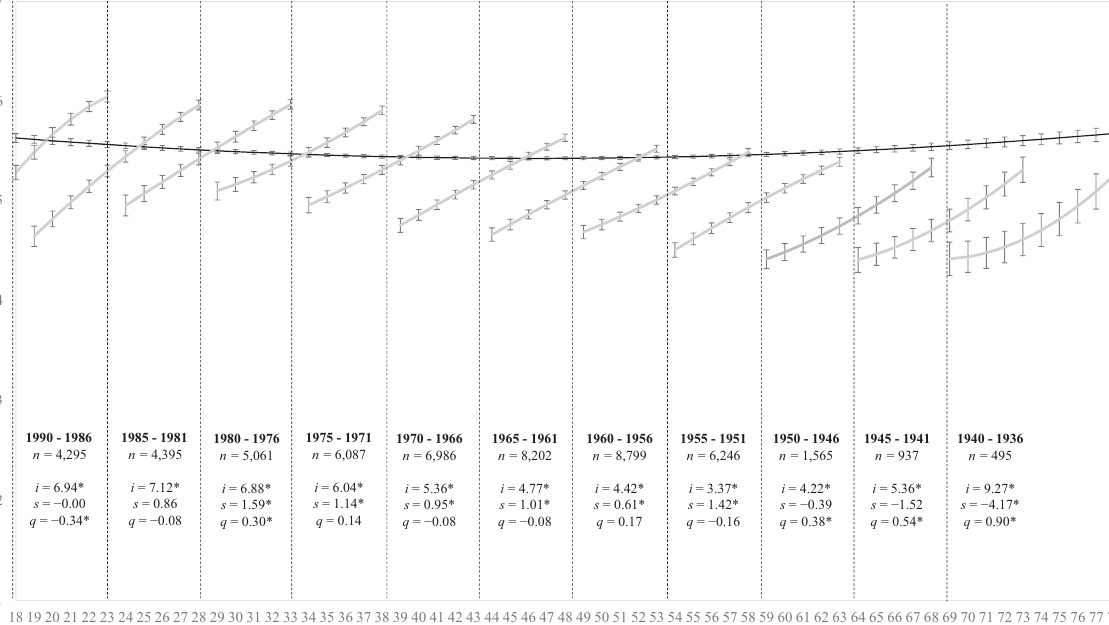
Fig. 2 Belief in anthropogenic climate change across age and fi ve-year birth cohorts. Model-implied change trajectories in the level of agreement with the statement “ Climate change is caused by humans ” (dark line) from ages 18 to 78. The lines within each 5-year cohort represent longitudinal change in human causation belief, estimating latent intercepts ( i ) as well as linear ( s ) and quadratic ( q ) slopes. The estimations are based on the mean-levels of human causation belief ( y -axis) across age and assessments ( x -axis) with 95% con fi dence intervals presented as error bars around each point estimate (* p < 0.05). Due to graphical space constraints, details for the 1995 – 1991 cohort are not shown but are n = 3399, i = 1.72, s = − 4.82*, q = − 1.29*. Respondents expressed their levels of disagreement – agreement on a 7-point answer scale anchored by 1 (strongly disagree) and 7 (strongly